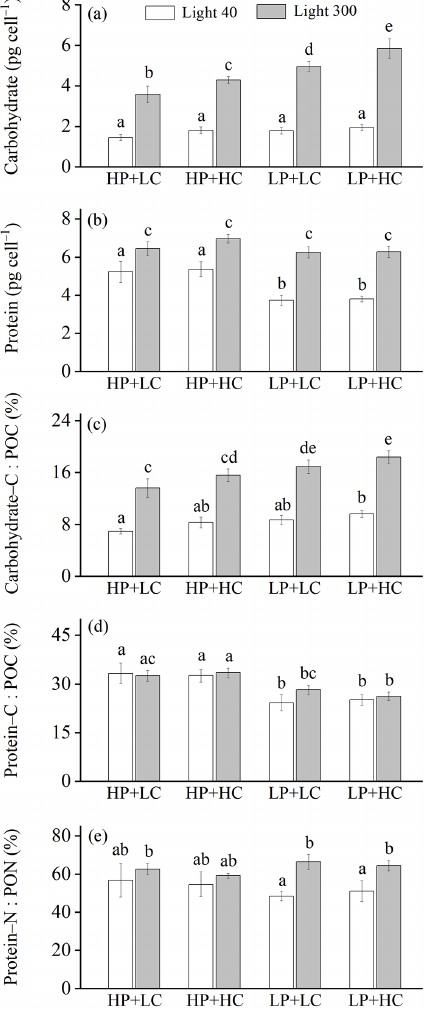
Figure 2. Cellular contents of carbohydrate (a) and protein (b) ; the percentages of POC allocated to carbohydrate (c) and protein (d) ; and the percentage of PON allocated to protein (e) of E. hux- leyi RCC1266 in the treatments of high phosphorus availability and low CO 2 level (HP + LC), high phosphorus availability and high CO 2 level (HP + HC), low phosphorus availability and low CO 2 level (LP + LC), and low phosphorus availability and high CO 2 level (LP + HC) under low light (empty) and high light (filled) in- tensities. Different letters represent significant differences in each parameter between treatments ( p < 0 . 05). The data represent the means and standard deviation of four independent